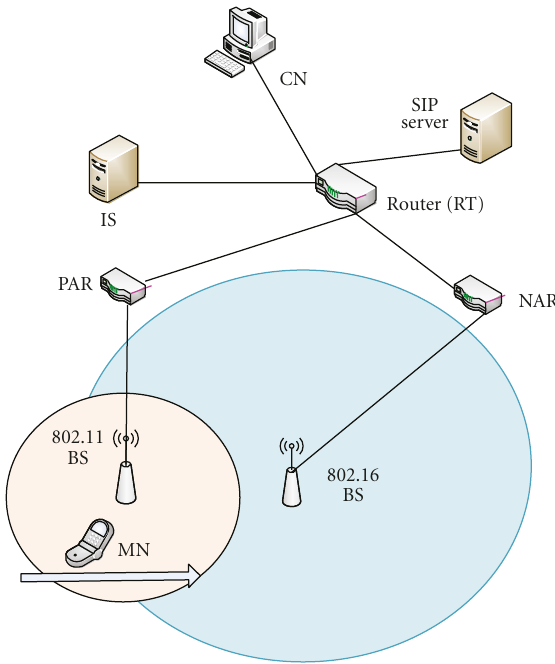
Figure 8: The simulation network model.